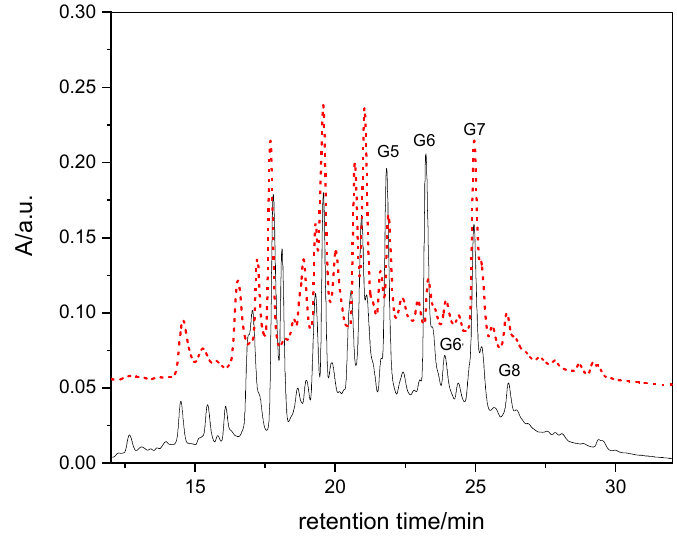
Figure 4. Surimposed HPLC-UV chromatograms extracted at 270 nm of aqueous extracts RME1 (black line) and RME2 (red dotted line) prepared at 0.19% in polyphenols.